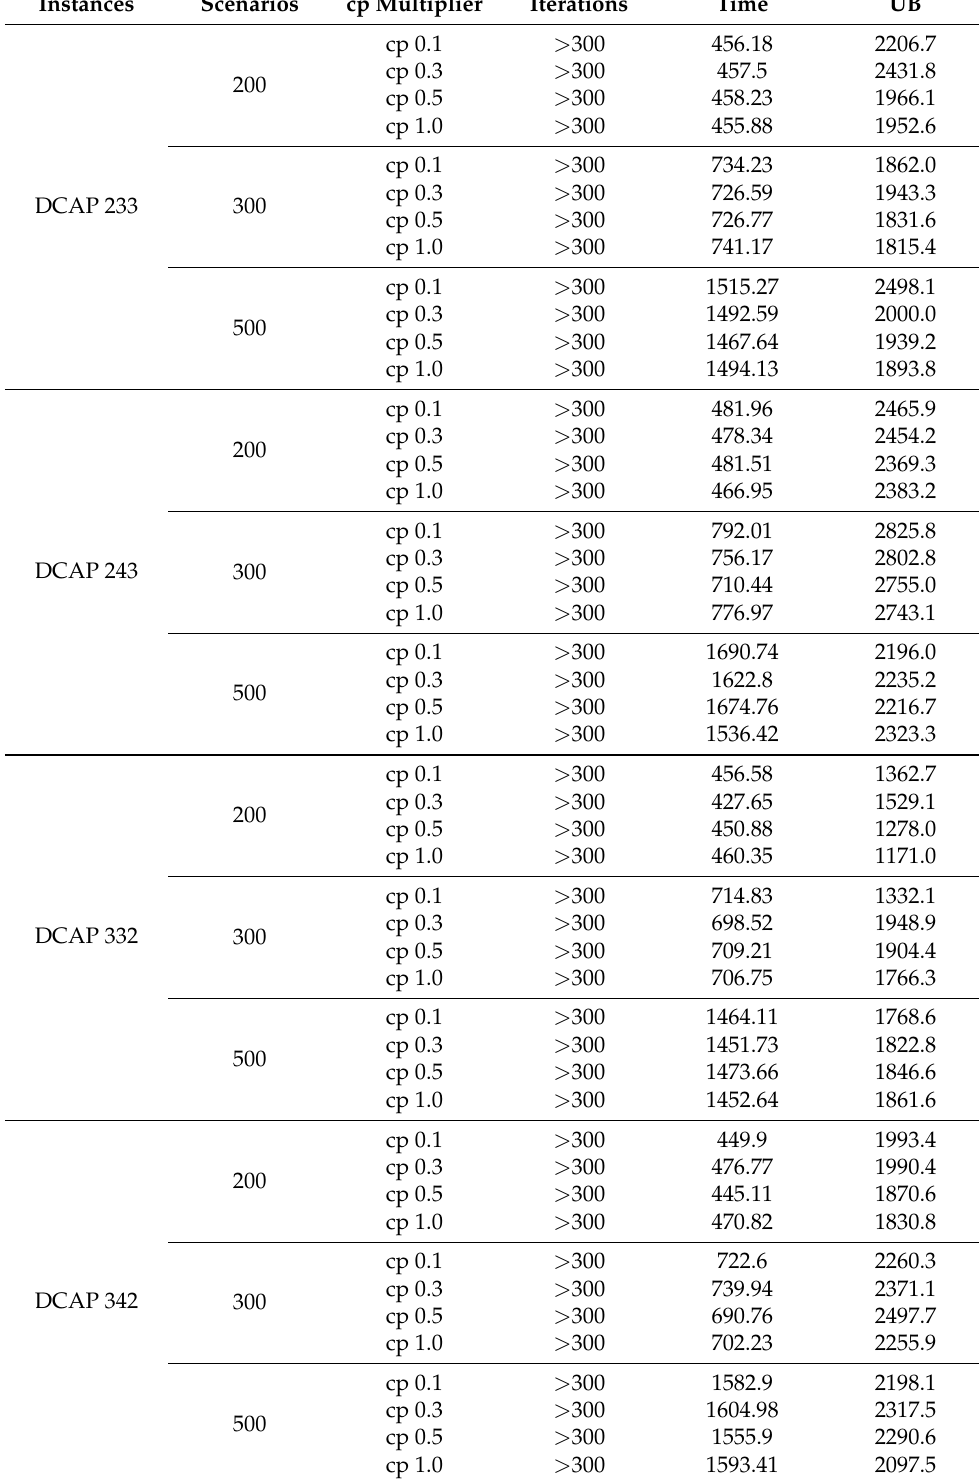
Table A3. Computational results for PySP on